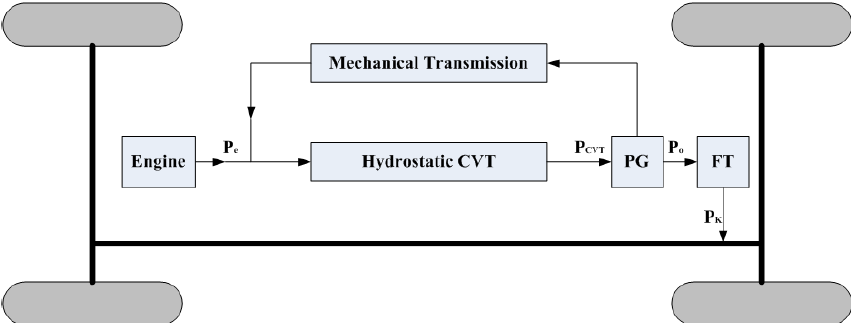
Figure 6. Mechanical transmission, backward power recirculation.